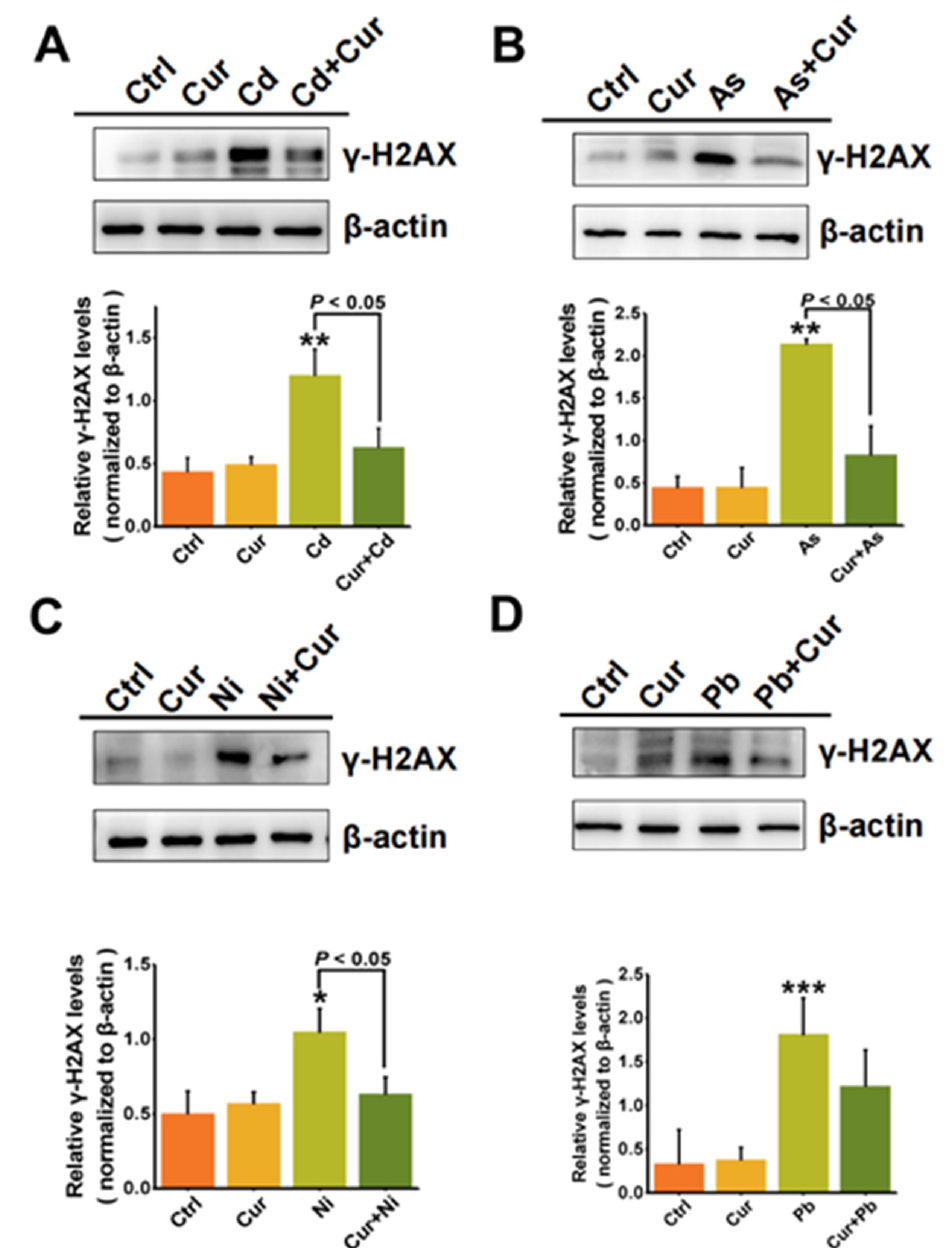
Figure 5. The antagonistic effects of curcumin on the genotoxicity of heavy metals ( A ) Cd, ( B ) As, ( C ) Ni and ( D ) Pb. Western blotting detection of the γ -H2AX protein levels in HepG2 cells exposed to curcumin (10 µM), Cd (6 µM), As (100 µM), Ni (2 mM), Pb (2.5 mM) and their co-treatments. β -actin served as a loading control. γ -H2AX levels were quantified by a densitometric analysis relative to β -actin. * p < 0.05, ** p < 0.01, *** p < 0.001.